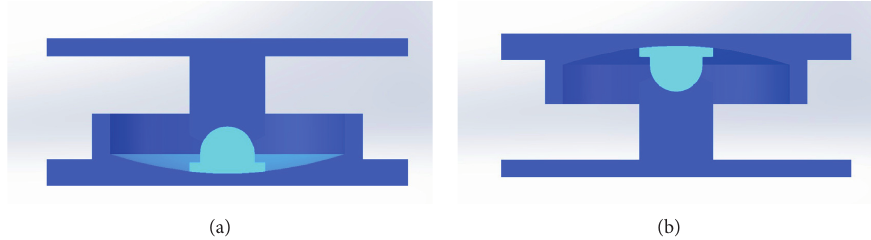
Figure 1: Friction pendulum system. (a) For base isolation. (b) For inter-storey isolation.